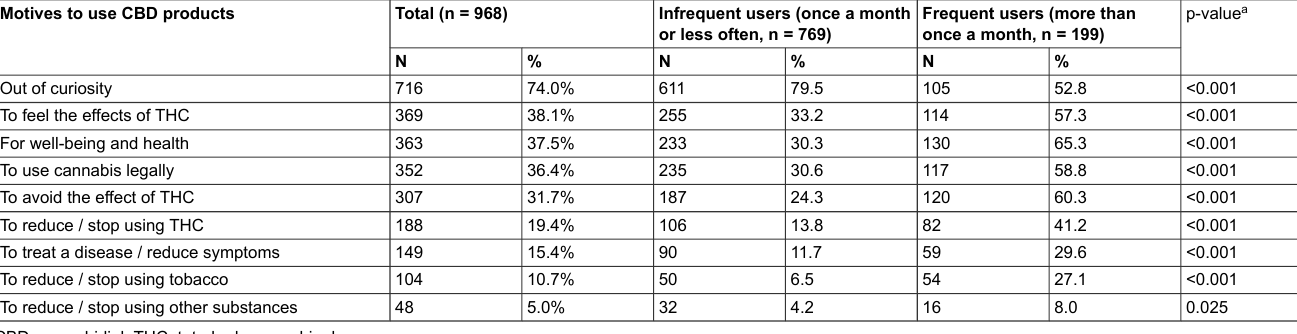
Table 3: Motives for using CBD products among users in the past 12 months (n =